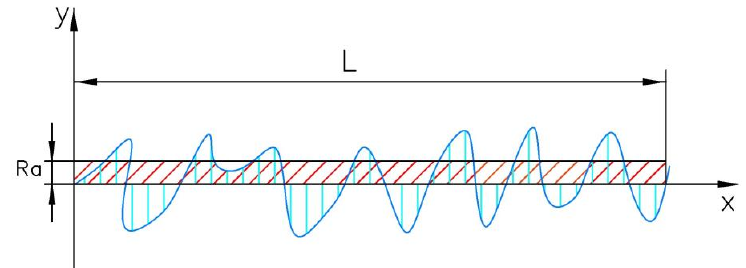
Figure 4. Parameters for evaluating surface